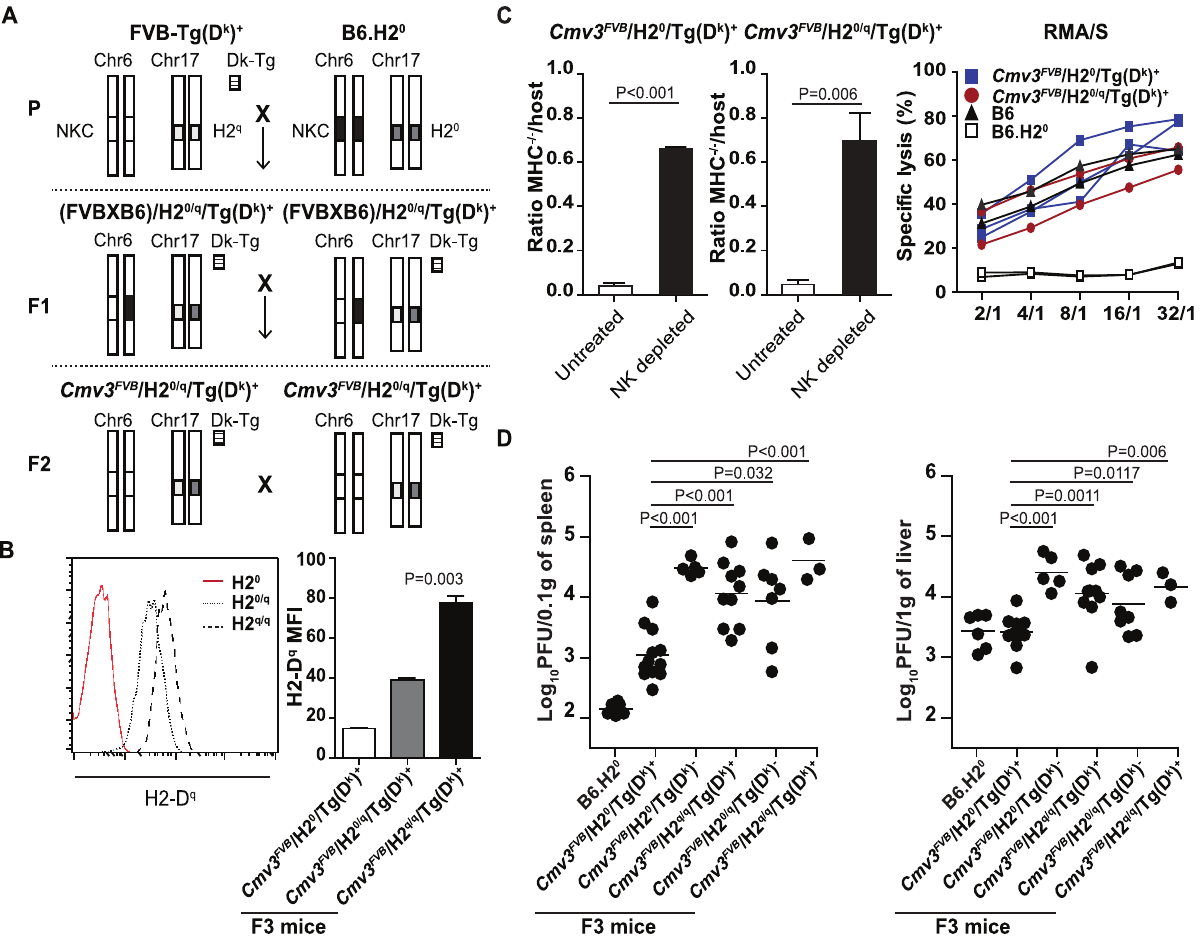
Figure 4. Functional characterization of F 3 mice carrying the NKC from FVB/N and different assortment of H2 molecules. (A) Breeding scheme for the generation of F 3 mice carrying the NKC loci from FVB/N parental mice and various combinations of H2 loci. The NKC, H2 , and H2 -D k transgenic loci are represented by boxes, as indicated. The parental (P) FVB-Tg(D k ) + and B6. H2 0 strains were mated to generate the F 1 generation. Subsequently, F 2 mice carrying an homozygous FVB/N NKC locus and heterozygous for either the H2 or the H2-D k transgene were kept and intercrossed to generate the F 3 mice with different H2 assortments ( H2 0 : H2-K b 2 / 2 D b 2 / 2 ). (B) H2-D q staining of lymphocytes from Cmv3 FVB /H2 0 / Tg(D k ) + ( H2 0 red peak), Cmv3 FVB /H2 0/q /Tg(D k ) + ( H2 0 /q , dot peak), and Cmv3 FVB /H2 q/q /Tg(D k ) + mice ( H2 q/q , dashed peak). Histograms on the right represent the quantification of the level of H2 -D q expression analyzed in three mice per group. (C) Rejection of B6 MHC class I–deficient cells in